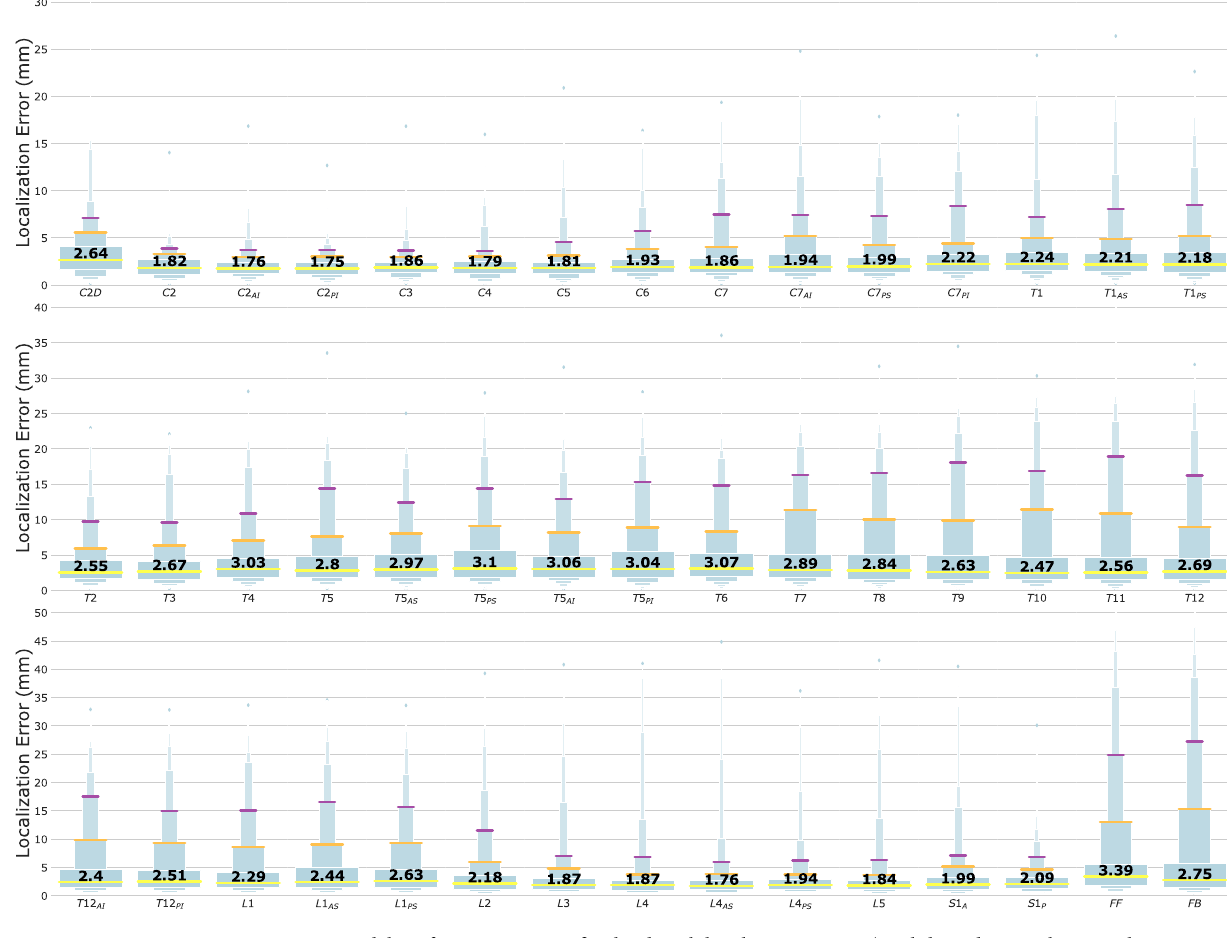
Figure 6. Model performance. Forty-five landmark localisation errors (Euclidean distance between human- annotated and machine-predicted coordinates) were visualised with boxenplots. The horizontal lines in yellow, orange and purple represented 0.5, 0.875, and 0.9375 error quantile, respectively. The value of error median (0.5 quantile) was also displayed using bold-font digits within each